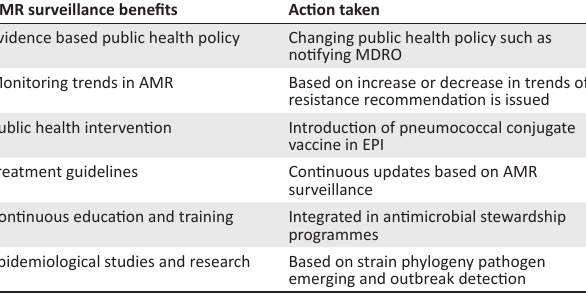
TABLE 2: Benefits of antimicrobial resistance